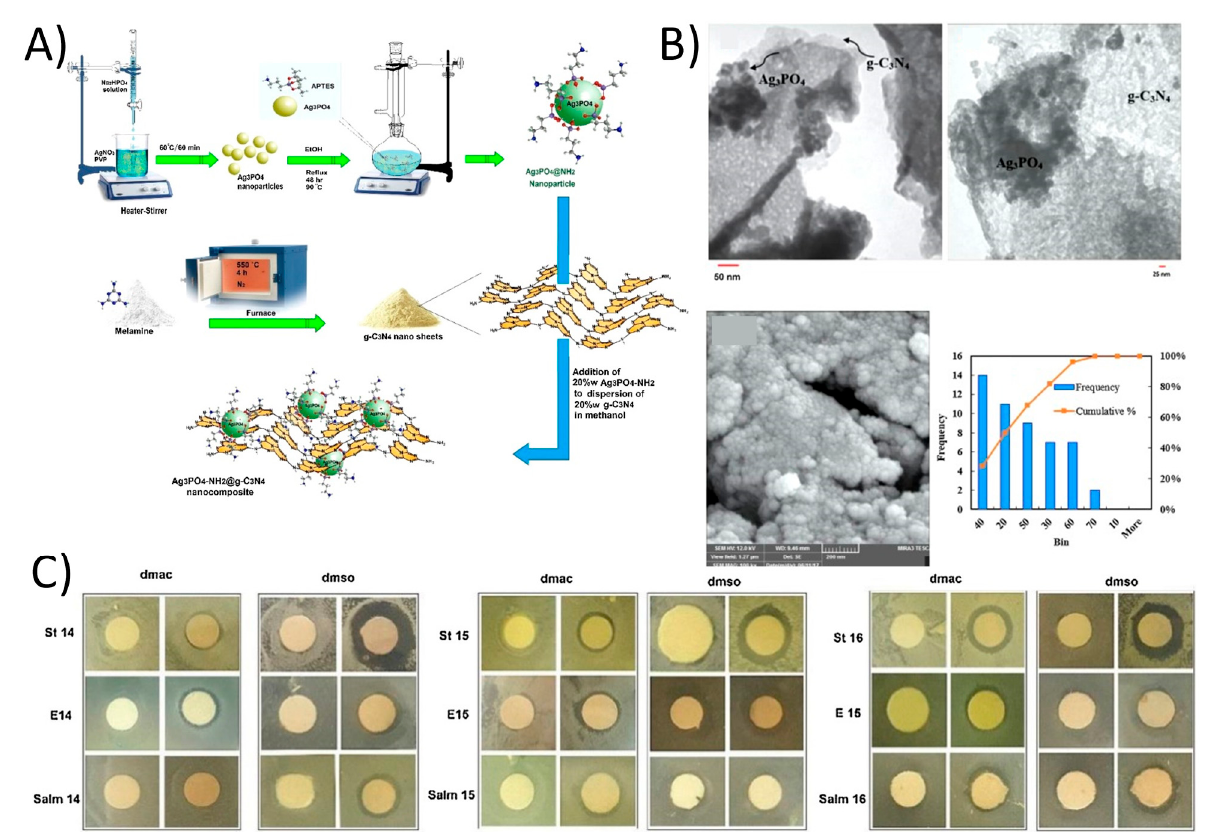
Figure 8. ( A ) The schematic of synthesis of Ag 3 PO 4 -NH 2 /g-C 3 N 4 nanocomposite and ( B ) TEM and FESEM images of Ag 3 PO 4 -NH 2 /g-C 3 N 4 along with nanoparticles size distribution chart. ( C ) The disc diffusion results of composite membrane against Escherichia coli , Staphylococcus and Salmonella (reproduced from [127] with permission from the Elsevier).